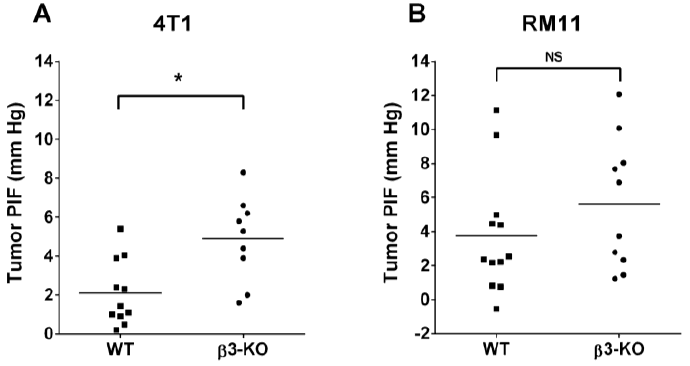
Figure 6. Interstitial fluid pressure (PIF) in individual 4T1 ( A ) and RM11 tumors ( B ) in WT and β3-KO mice. * p < 0.005, NS indicates no statistical significance ( p = 0.24).